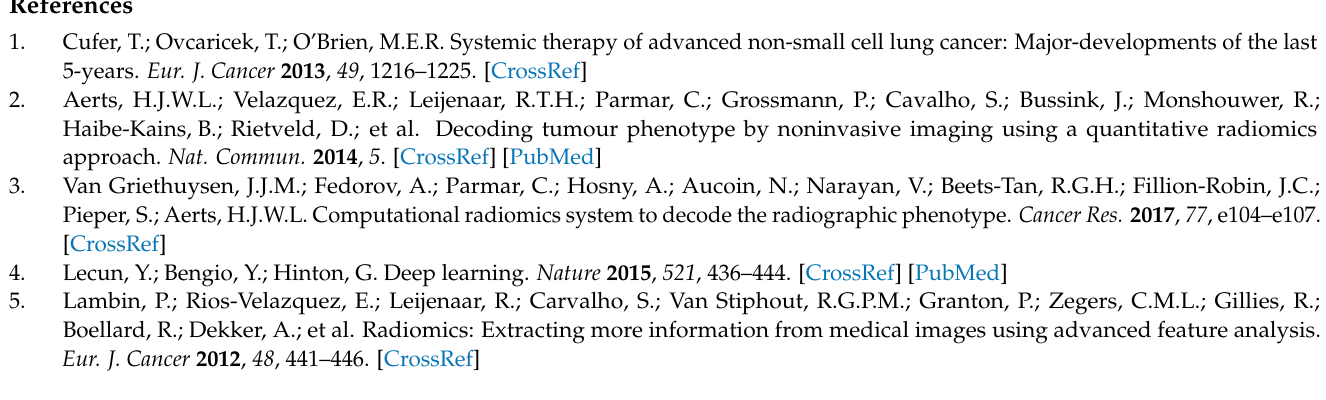
Figure S2: Correlation among radiomic features, Figure S3: Number of features correctly selected as associated with the outcome, Figure S4: Sensitivity and specificity for unbalanced datasets with and without SMOTE correction for large dataset, Figure S5: Sensitivity and specificity for unbalanced datasets with and without SMOTE correction for medium dataset, Figure S6: Sensitivity and specificity for unbalanced datasets with a without SMOTE correction for small dataset, Figure S7: Heatmap representing the predictive performance (AUC) in the validation set for unbalanced SMOTE samples, Table S1: Baseline characteristics of the original study population, Table S2: Wilcoxon p - values for the association of features F1, F2 and F3 with outcome. References [29–32,49–51] are